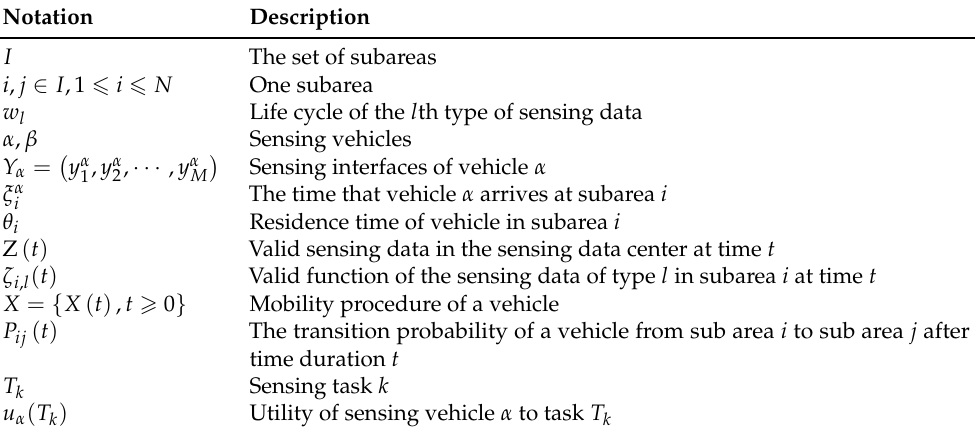
Table 1. List of